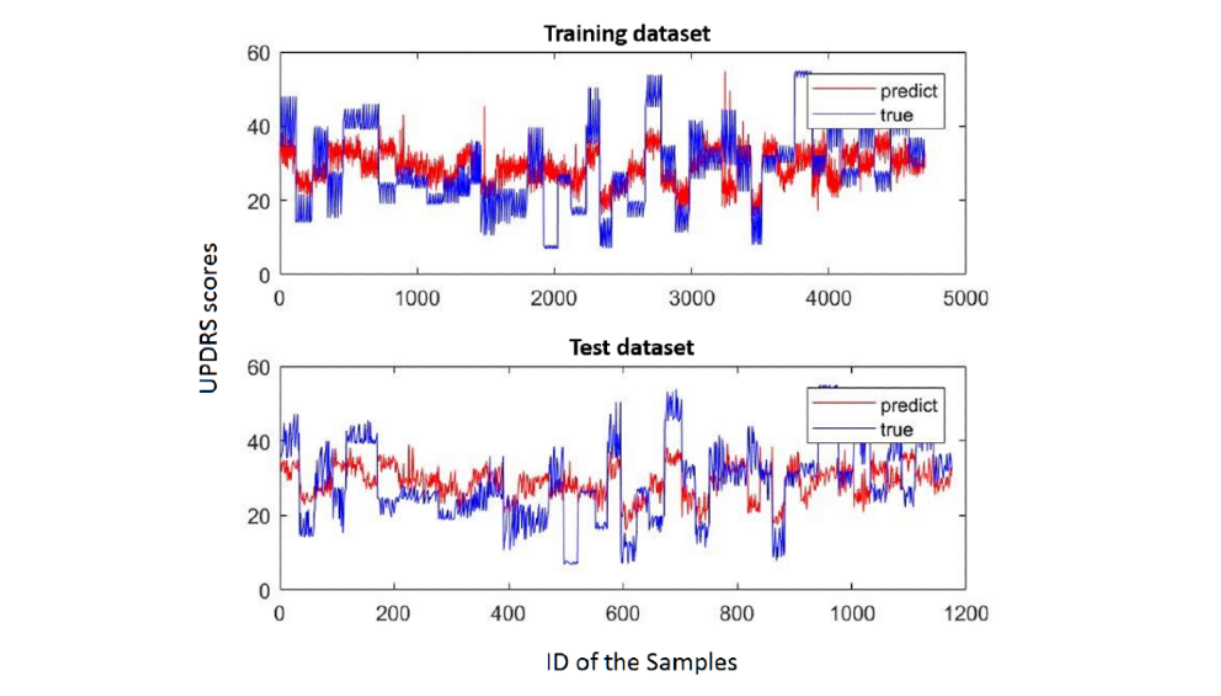
Figure 3. Linear regression fitting. The red line is the predicted value and the blue line is the true value. UPDRS: Unified Parkinson's Disease Rating Scale.